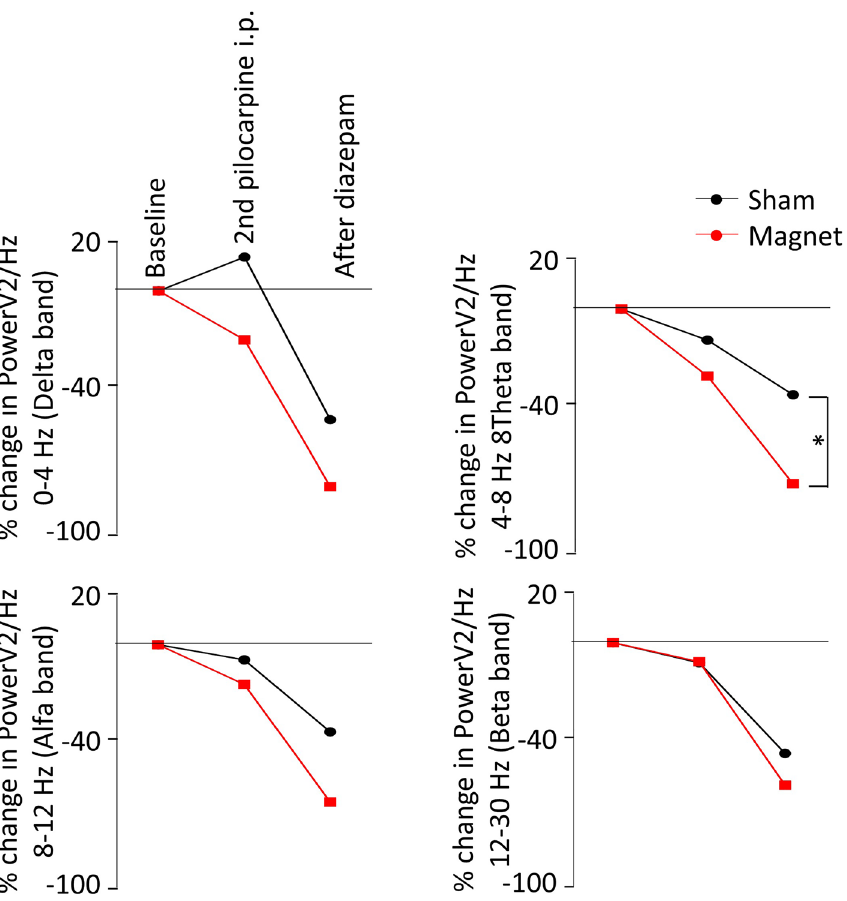
Figure 4. ( a ) Power averaged across frequencies are averaged values from 8 pair of animals (diazepam dose 1.25 mg/kg). Significant differences between Sham and Magnet * p < 0.05. Black, sham rats; red, magnet rats.